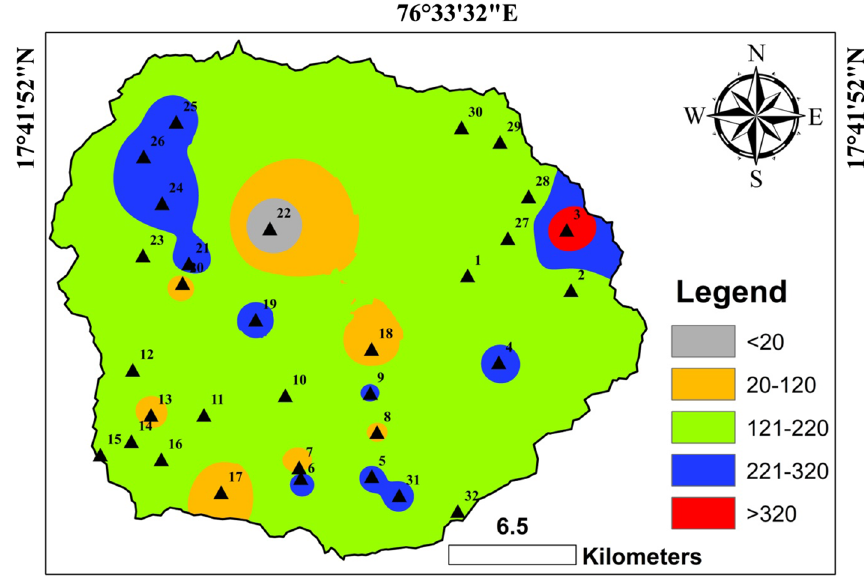
Fig. 21 Geospatial distribution of bicarbonate